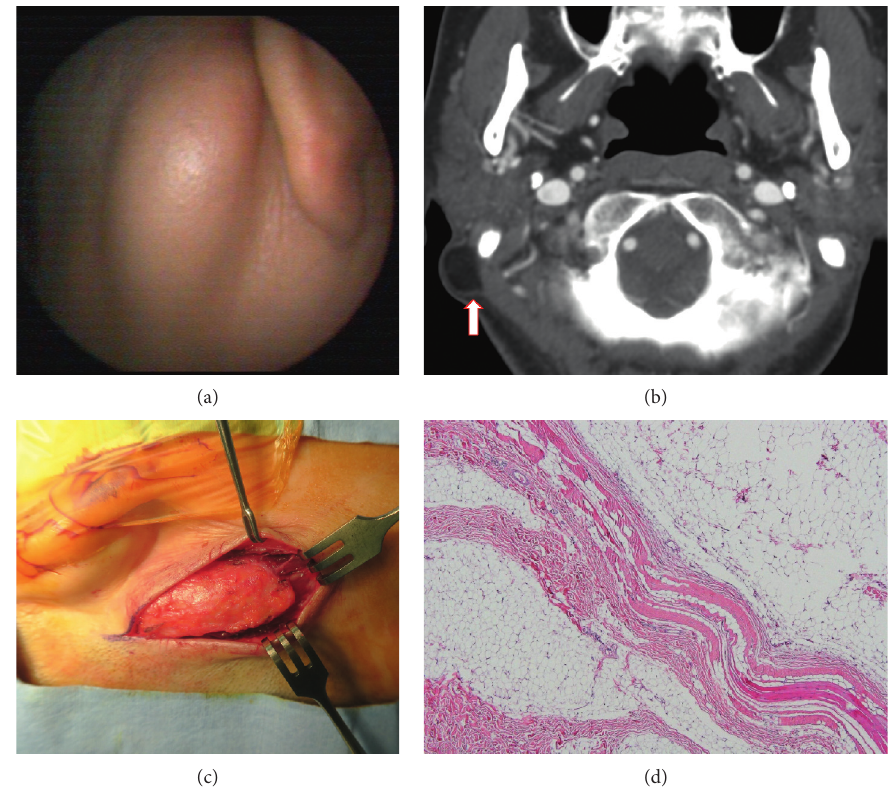
Figure 1: Right postauricular bulging mass which is asymptomatic, soft, and slightly movable (a). The temporal bone computed tomography shows a well-defined, low-attenuated, and nonenhancing mass (arrow) lateral to the mastoid process (b). Intraoperative view of a well- circumscribed intramuscular benign lipoma (c). A benign lipoma surrounded by muscle fibers. The tumor was composed of mature adipocytes without lipoblasts or cytologic atypia (d) (H&E ×